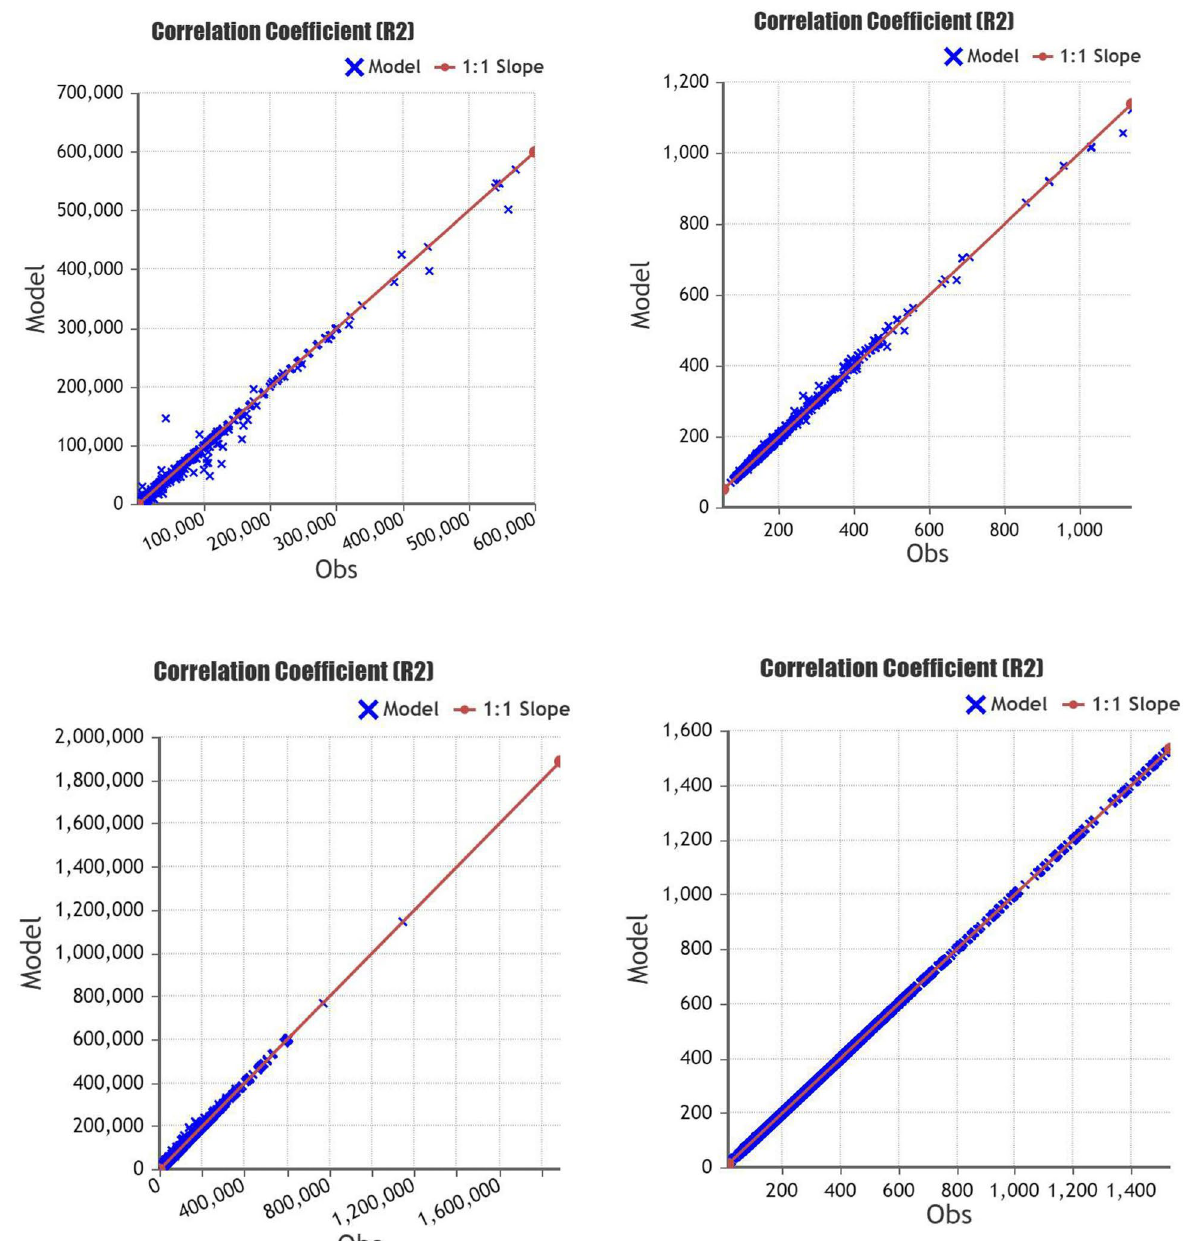
Fig. 3 Evaluation of percentiles for execution time (left-figures) and memory utilisation (right-figures) using Coefficient of determination: the result of previous generator approach (top 2 plots), and proposed approach using GA (bottom 2